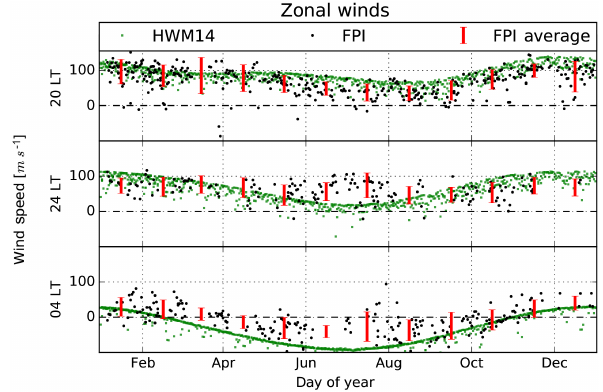
Figure 9. A comparison of measured zonal winds to HWM at fixed local times of 20:00, 24:00, and 04:00. The black dots represent a binned measurement, the red bars represent monthly averaged FPI estimate, and the green dots represent the HWM14 airglow-weighed estimate. Positive values are